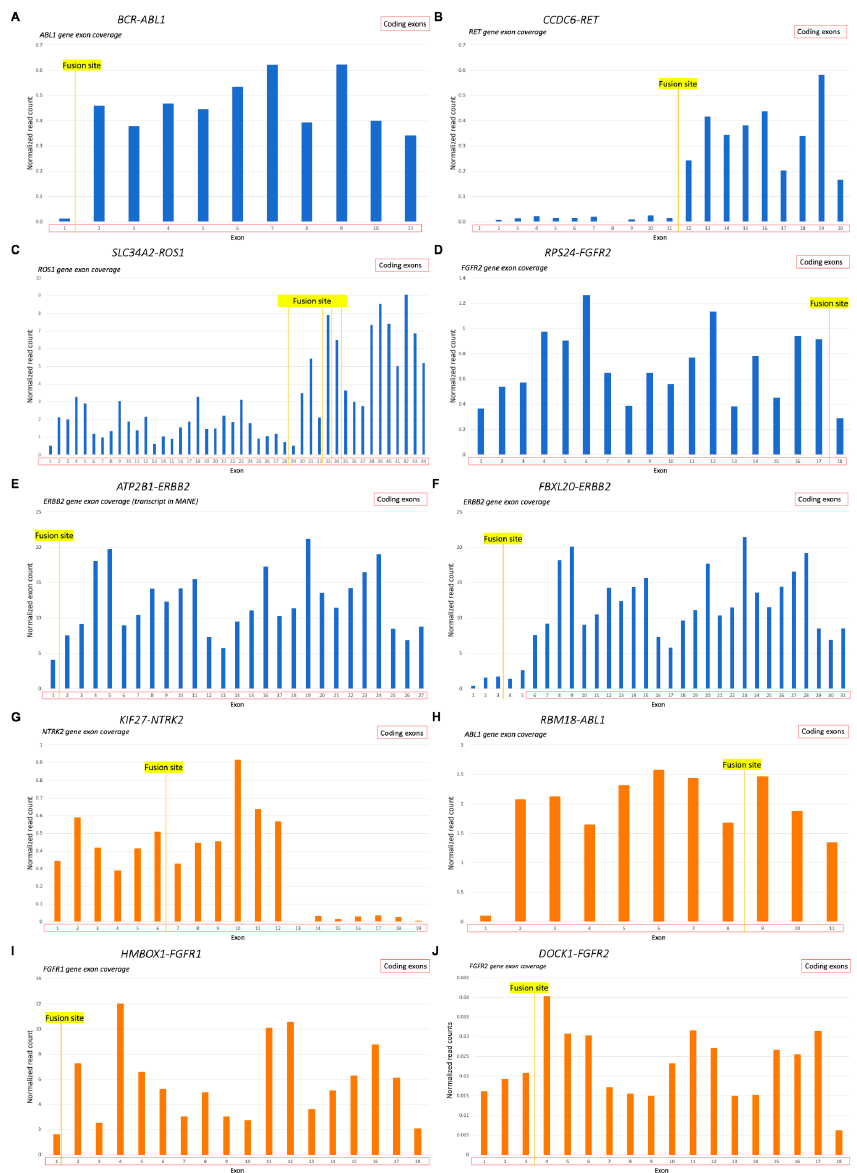
Figure 5. The 3 ′ fusion partner gene exon coverage, investigated for the 3 ′ RTK fusion transcripts: ( A ) length-normalized RNAseq reads coverage of ABL1 gene in sample AL98 ( BCR-ABL1 fusion); ( B ) length-normalized RNAseq reads coverage of RET gene in sample FS1 ( CCDC6-RET fusion); ( C ) length-normalized RNAseq reads coverage of ROS1 gene in sample LuC46 (SLC34A2-ROS1 fusion,